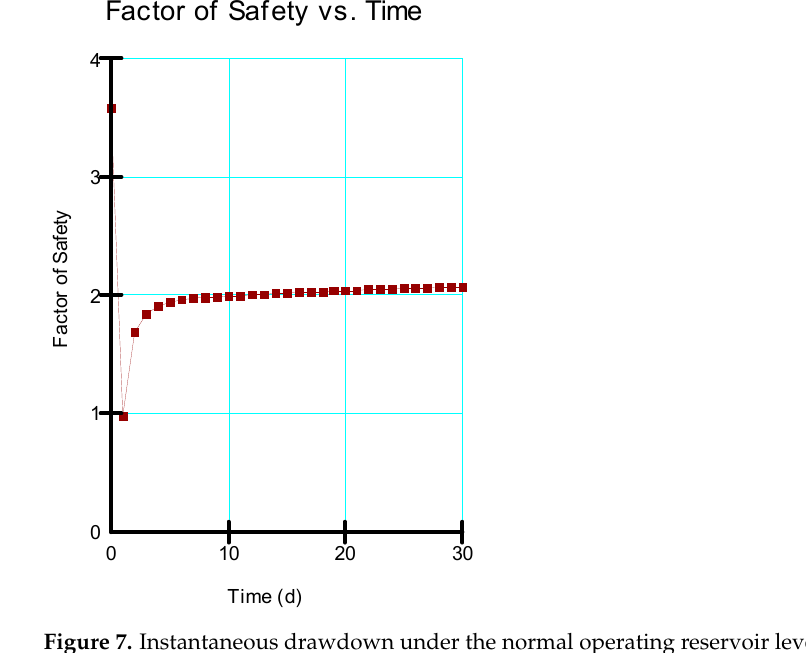
Figure 7. Instantaneous drawdown under the normal operating reservoir level.